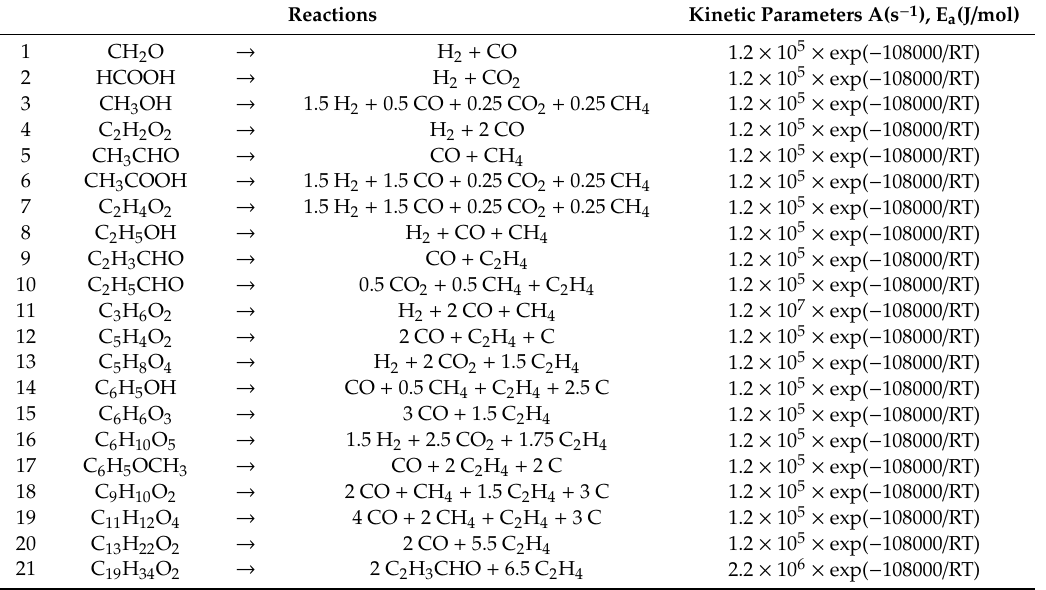
Table 7. Secondary tar cracking